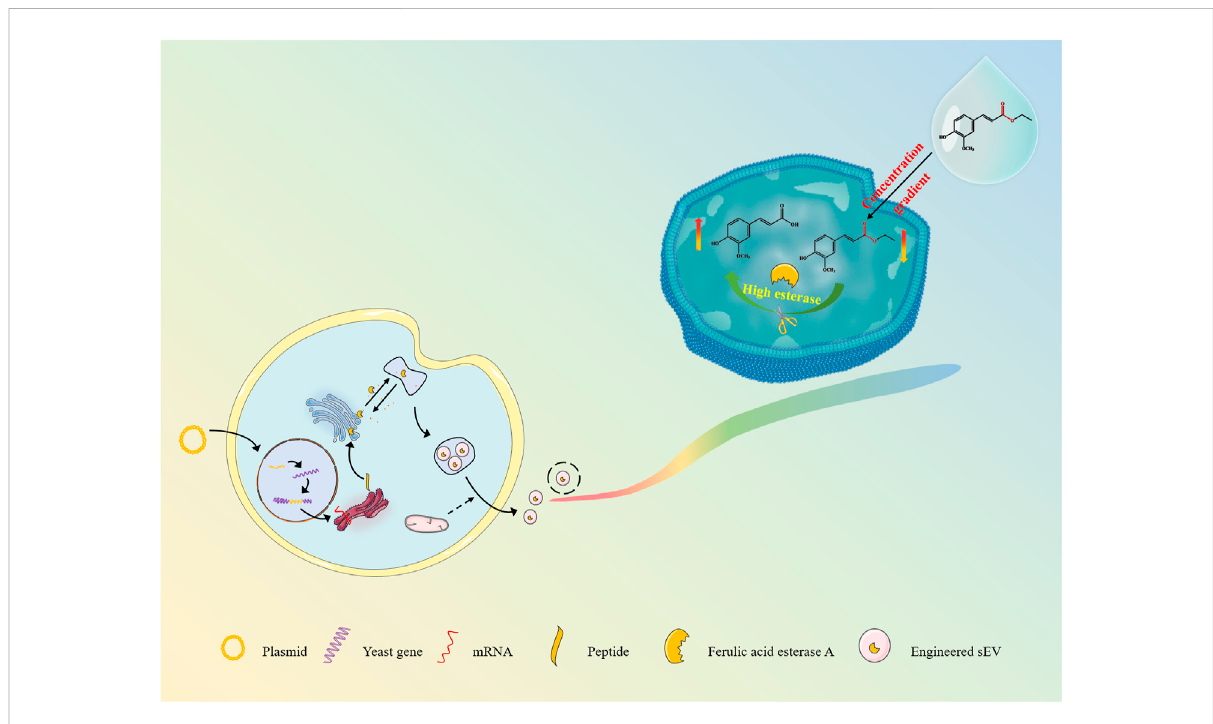
FIGURE 1 Scheme of sEV delivery system for ef fi cient loading of hydrophilic